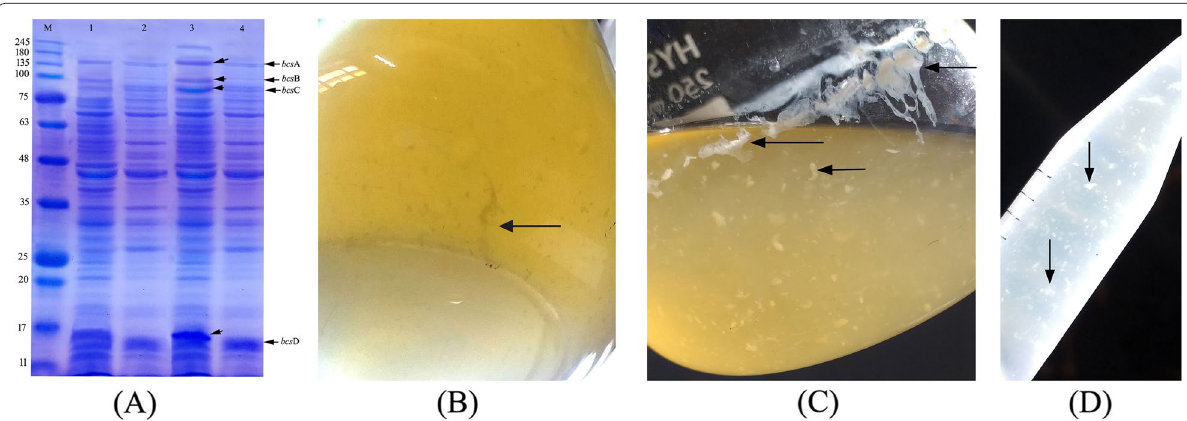
Fig. 4 SDS‑PAGE (14%) showing the profile of resolved recombinant bcs ‑proteins in induced cultures of E. coli . The four bcs ‑recombinant proteins were detected as the expected molecular weights in both B21 (DE3) and DH5α induced cultures (lanes 3 and 4, respectively), but their overexpression was more pronounced in later compared to control uninduced cultures of B21 (DE3) and DH5α (lane 1 and 2, respectively) ( A ). BC was detected as white gel‑like dispersed structures in E. coli DH5α 1 h after IPTG induction ( B ), and it continued to accumulate in culture media until it was visualized as white filaments 18 h post‑induction ( C ). A less dense BC production was detected in uninduced DH5α cultures suggesting a leaky expression ( D